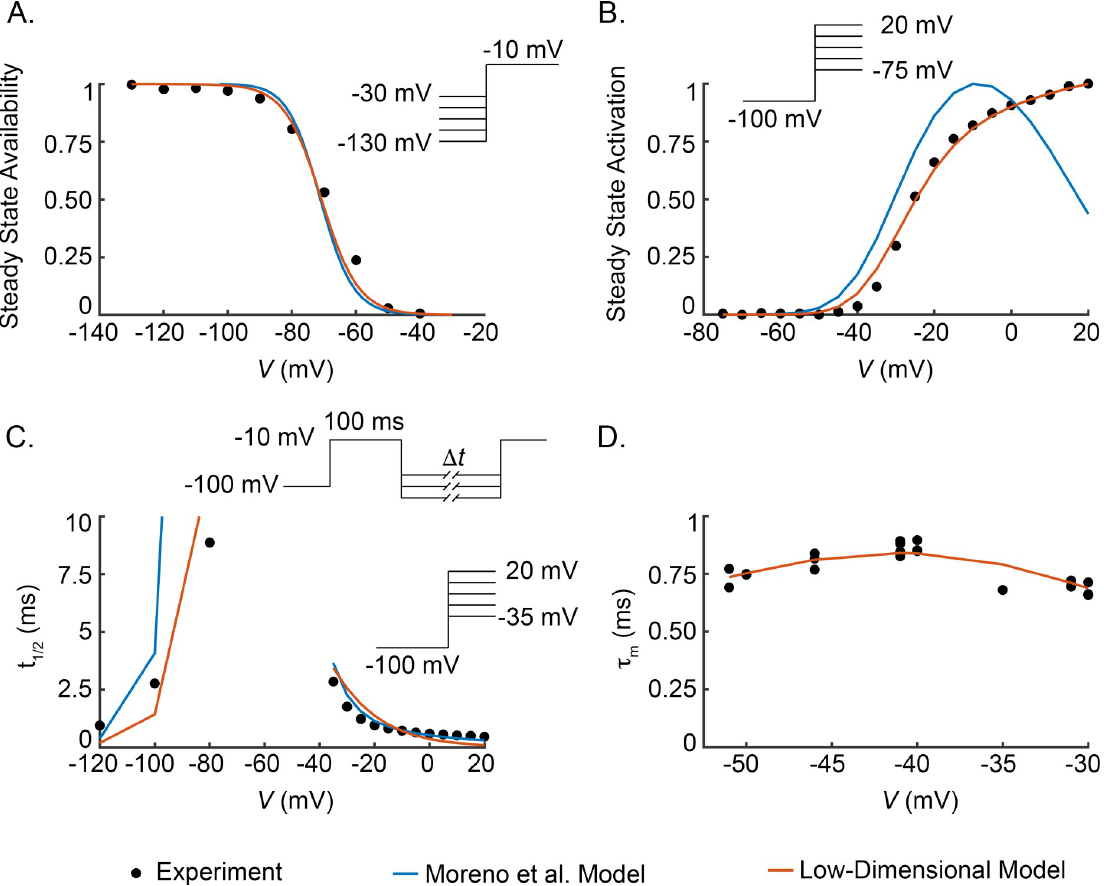
Fig 2. Drug-free data. The low-dimensional Na + conductance model is fit to experimental data from steady state availability (A; sum squared errors (SSE) of 0.038 and 0.035 for the Moreno et al. and low-dimensional models, respectively), steady state activation (B; SSE of 0.042 and 7.0 × 10 − 4 for the Moreno et al. and low-dimensional models, respectively), time to half inactivation (C; SSE of 197 and 17 for the Moreno et al. and low-dimensional models, respectively), and time constant of activation (D; SSE of 1.4 × 10 − 3 for the low-dimensional model) voltage-clamp experiments [17–19]. In all subfigures, filled circles indicate experimental data points, blue curves represent output from the Moreno et al. model [4], orange curves represent output from the low-dimensional Na + conductance model. t 1/2 at -80 mV in the Moreno et al. model is not indicated in the figure as it is substantially larger (48.8 ms) than the other t 1/2 values. For the low-dimensional P n ¼ 1 : SSE ¼ 1 ð y (cid:0) x Þ 2 , n is total number of data points, { y } are the model output, and { x } are the experimental model in (D), t i i m i i i ¼ 1 a m þ b m n data